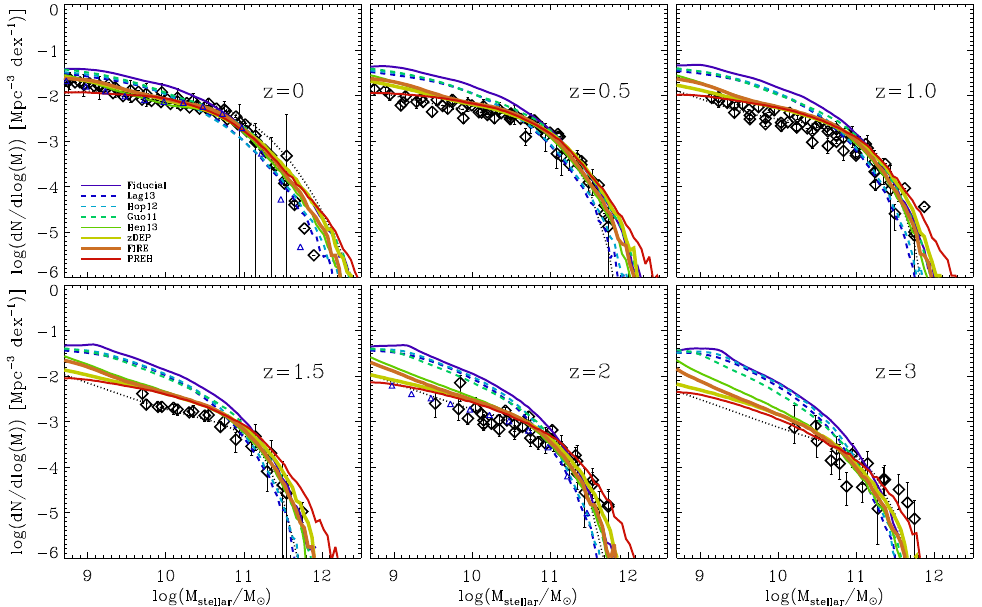
Figure 4. Figure from Hirschmann et al. [59]. The figure shows the redshift evolution of the galaxy stellar mass function for different stellar feedback models (lines of different colors; see the original paper for more details on individual parametrizations). Symbols with error bars show a combination of observational